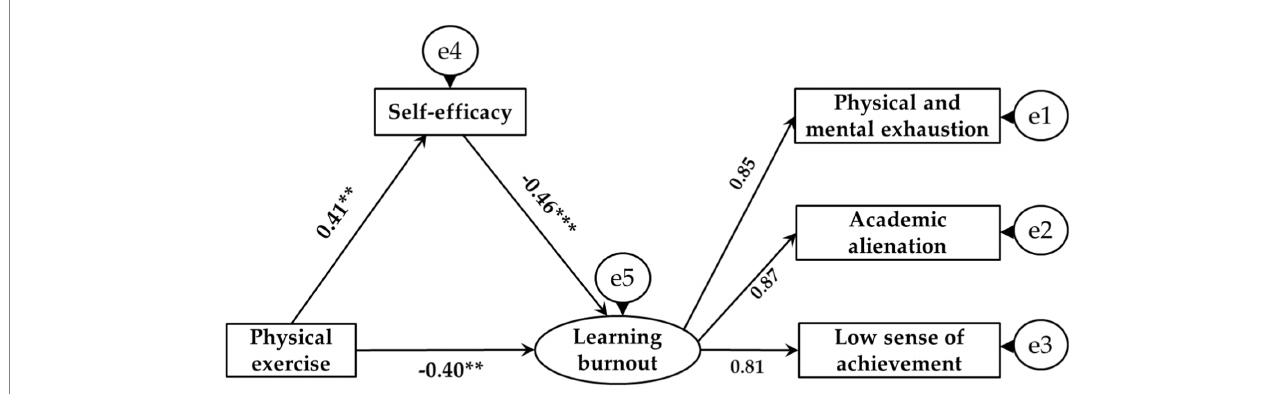
FIGURE 1 The mediating path model diagram of physical exercise influencing learning burnout. ** p < 0.01, *** p < 0.001.